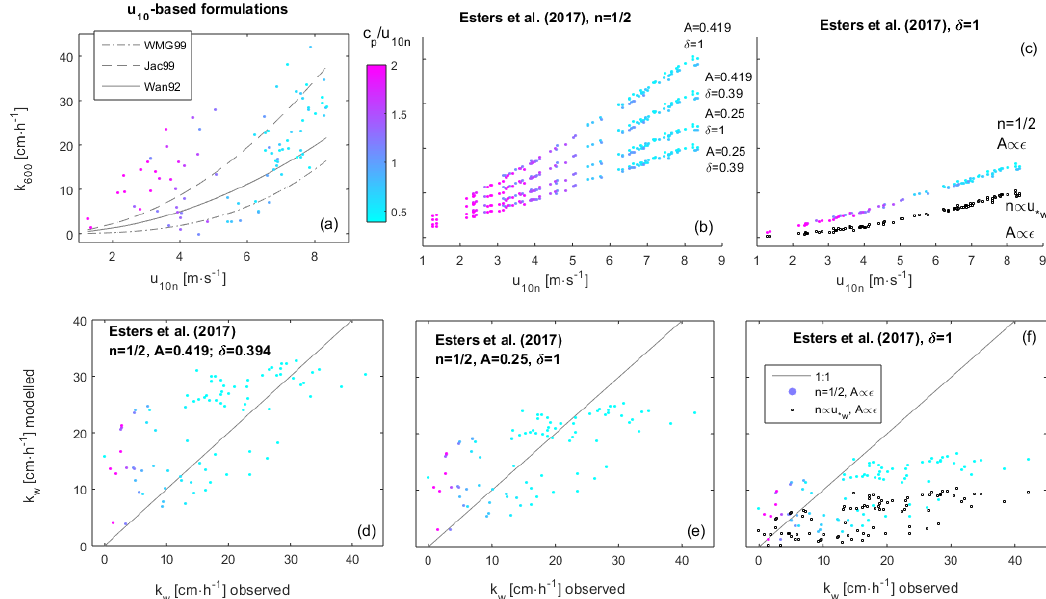
Figure 6. Estimation of k wind term. ( a ) The transfer velocity standardized for CO 2 in fresh-water at 20 ◦ C (k 600 ) estimated from (EC data) direct observation obtained through EC method for 2014 and 2015, and relation with (u 10n ) wind speed (c p / u 10n ) and wave age. Waves aged c p / u 10n > 1 correspond to overdeveloped sea. The EC transfer velocities were compared with ( a ) those estimated from the u 10 -based formulations by Jacobs et al. [83] (Jac99), Wanninkhof [18] (Wan92) and Wanninkhof and McGillis [84] (WMG99), and ( b – f ) with comprehensive physically-based algorithms (u * -based) by Esters et al. [30]. [Equations (17) and (18)]. ( a , b ) k 600 estimated from Esters et al. [30] algorithm and its relation with u*. ( d – f ) validation of k 600 estimated from from Esters et al. [30] algorithm against k 600 estimated from direct observation obtained through EC method.